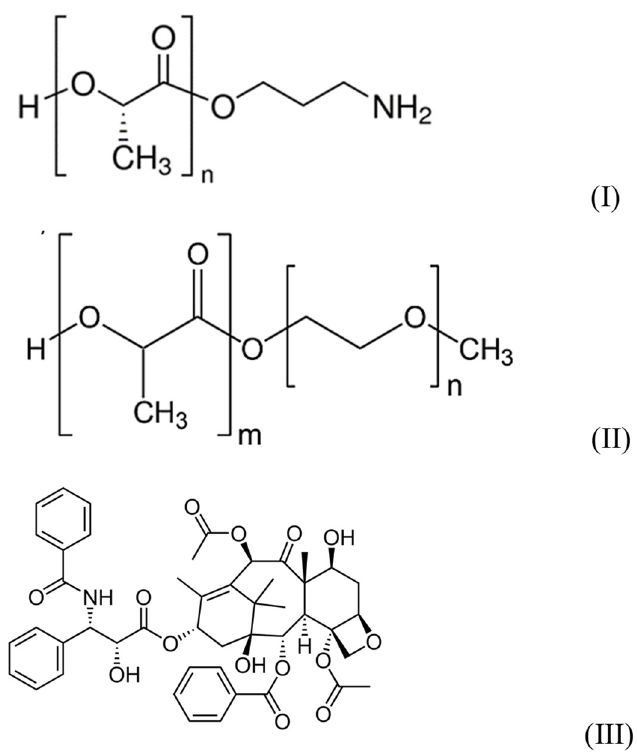
Figure 1. Structures of